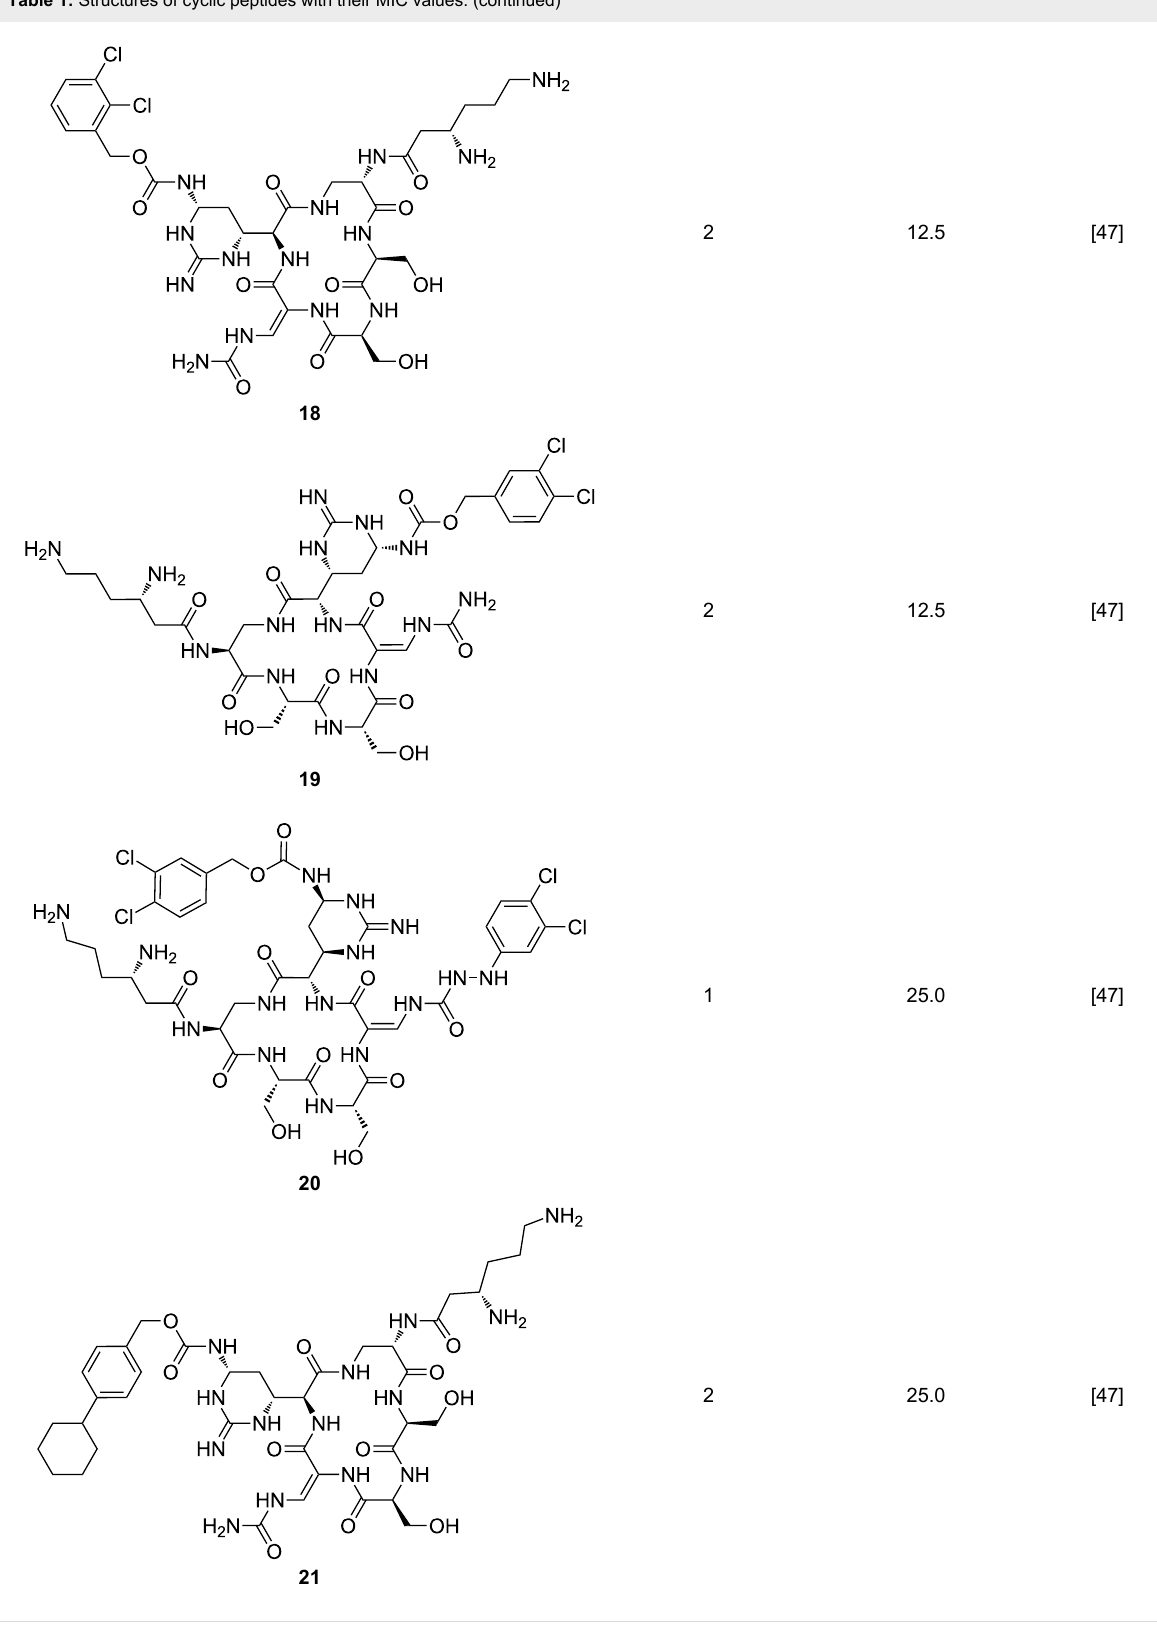
Table 1: Structures of cyclic peptides with their MIC values.